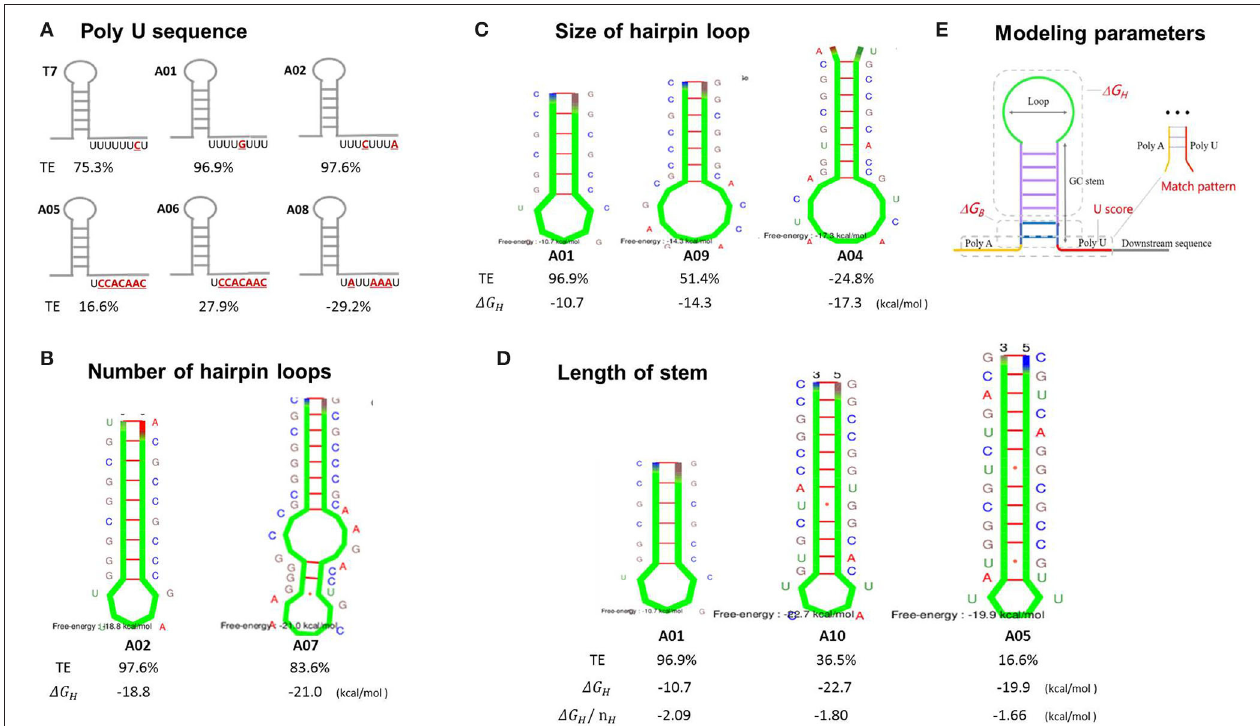
FIGURE 3 | The analysis of the main contributors to the termination efficiencies of terminators. All of the hairpin structures were predicted by Kine Fold using only the stem-loop sequence, without the poly A and poly U sequence nor the upstream and downstream text. The main contributors to termination efficiency were analyzed individually: the contribution of the poly U sequence (A) , loop numbers (B) , loop size (C) , and stem length (D) . Taken together, A preliminary model was established to predict termination efficiency based on the parameters indicated in (E) . TE, the termination efficiency. 1 G H , the free energy for stem-loop structure formation without the upstream and downstream context. 1 G H / n H , the normalized free energy for the stem-loop structure